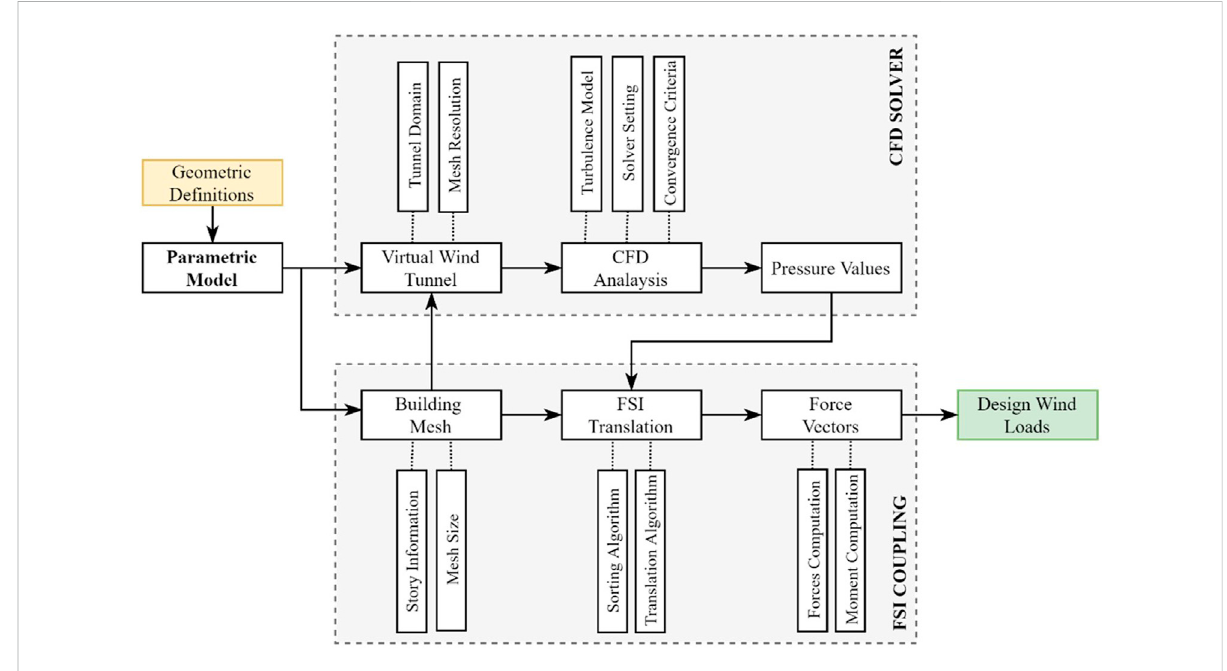
FIGURE 1 Computational wind loads generation